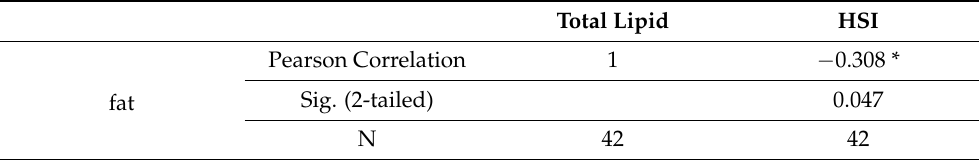
Table 9. Pearson correlation coefficient between total lipid (fat) and HSI.